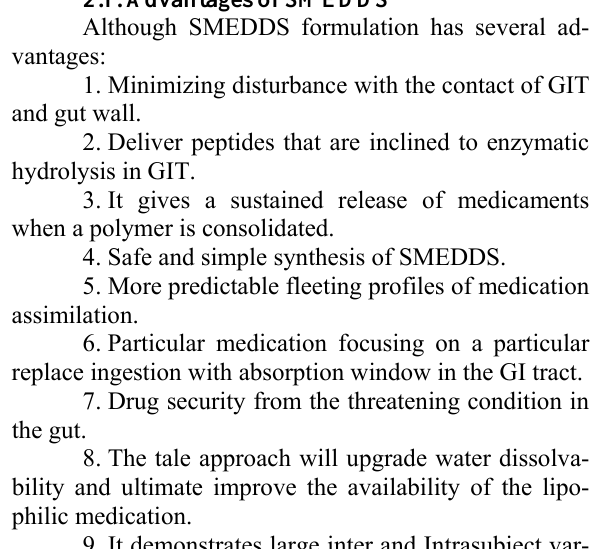
Fig.1. Mechanism of action of self-micro-emulsifying drug delivery system on oral administration of